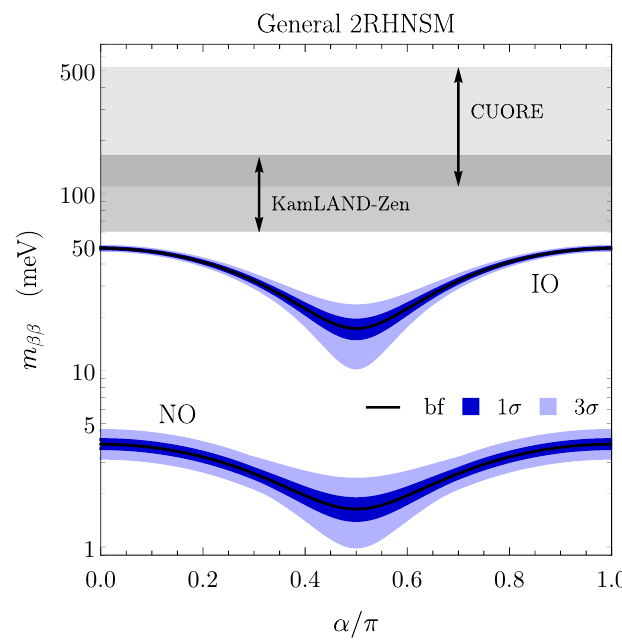
Figure 5 . m (cid:12)(cid:12) predictions as a function of (cid:11) for the general 2RHNSM (NO and IO). The dark (light) blue regions were obtained using eqs. (4.2) and (4.3), and varying (cid:18) ij and (cid:1) m 2 3 (cid:27) (1 (cid:27) ) experimental ranges given in table 1. The solid black curves correspond to m (cid:12)(cid:12)